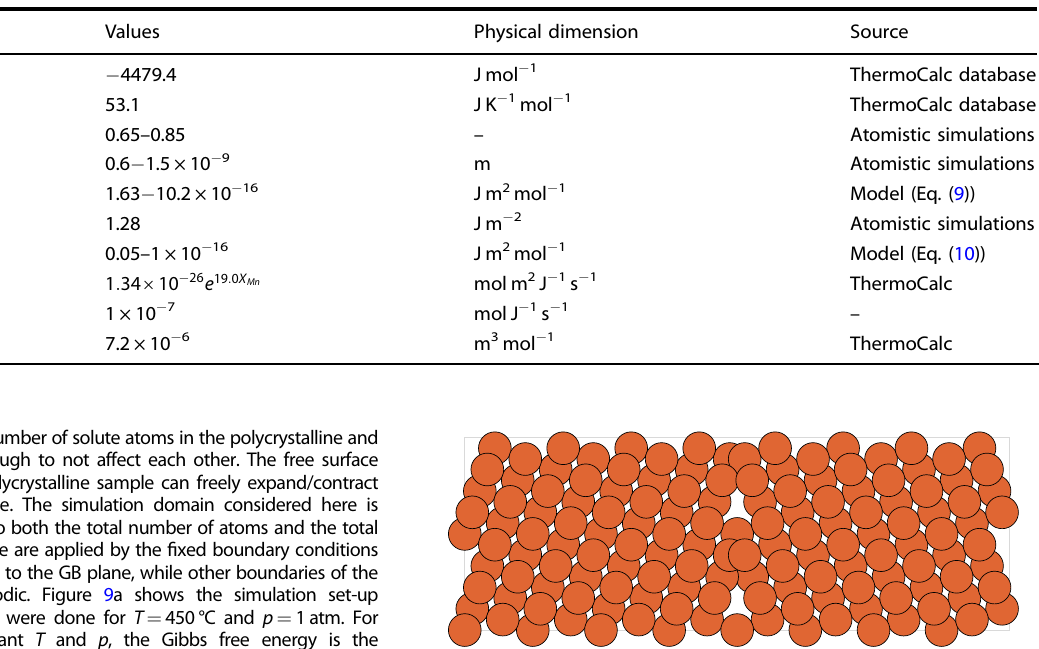
Fig. 9 Simulation set-up. a The large-grain polycrystalline sample and the simulation set-up of a single fl at GB are schematically shown. We apply fi xed boundary conditions parallel to the GB plane while other boundaries are periodic. b The enthalpy of mixing of Fe – Mn system is shown at 450 °C. Table 1. Input parameters for the current simulation studies.